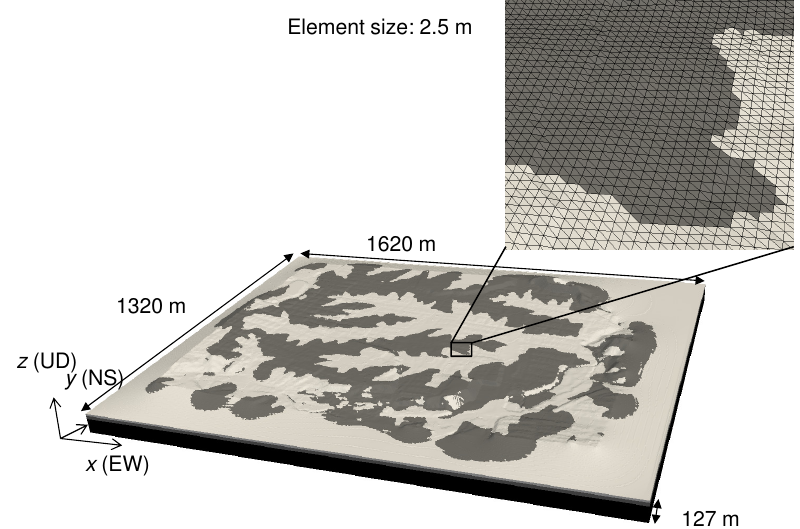
Figure 2. Target area. ( a ) Dark gray areas indicate cut ground (hard), while light gray areas indicate fill ground (soft). Black lines indicate position of pipeline. Here, pipeline is buried 1.2 m below the surface. Circles indicate the position of pipeline damage during the 2011 Tohoku Earthquake. ( b ) Elevation of cut/fill-layer interface. White lines indicate the cut/fill-layer interface.